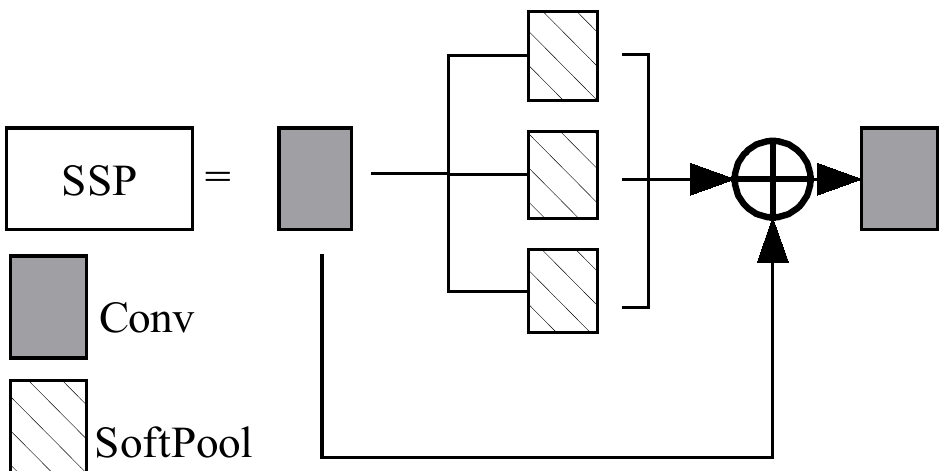
Figure 9. SSP improvement module.